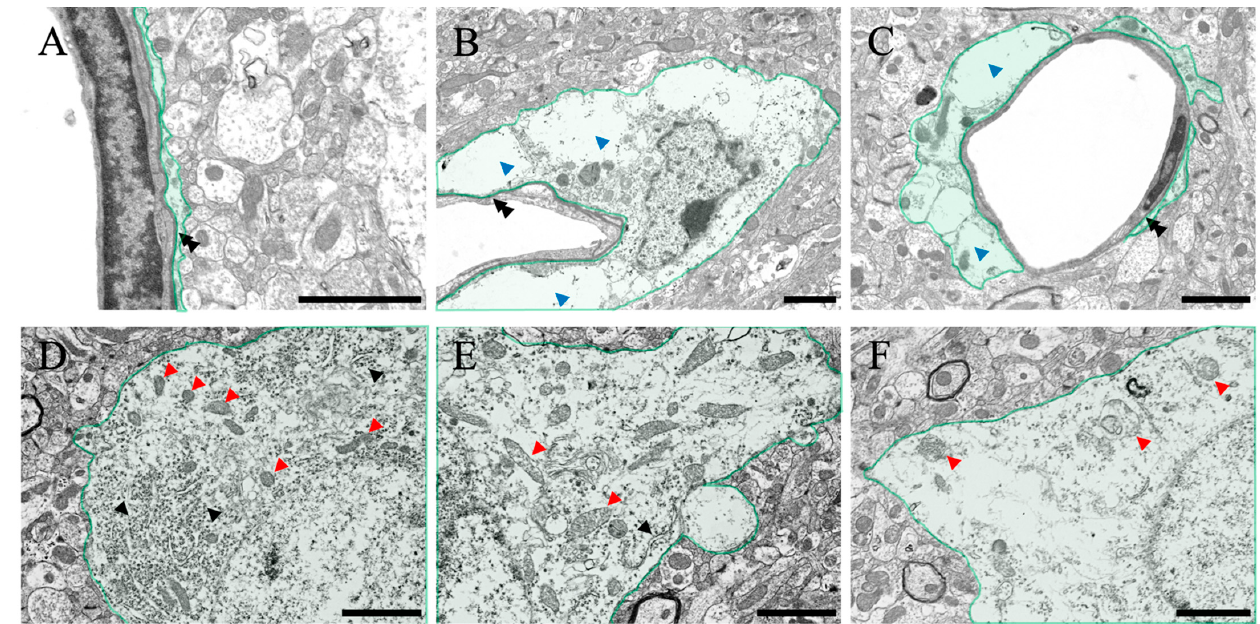
Figure 6. Control ( A , D ), 3H ( B , E ), and 24H ( C , F ) representative electron microscopy images of the cerebral cortical tissues from the control animals and those from animals sacrificed 3 h and 24 h after ammonia treatment, respectively. ( A – C ) show the blood vessel and perivascular astrocytes in the cerebral cortex (green color). ( D – F ) show the neurons in the cerebral cortex (green color). Black double arrowheads show the basal membrane. Blue arrowheads indicate the perivascular edema of the cerebral cortex layer II/III. Black arrowheads indicate the rough endoplasmic reticulum. Red arrowheads indicate mitochondria. All scale bars = 2 µm.